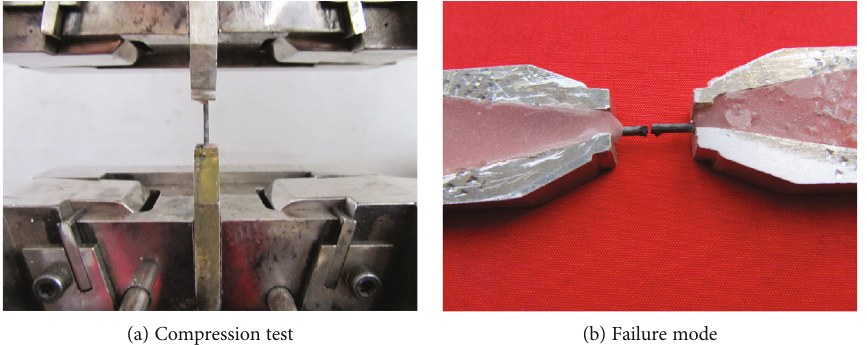
Figure 4: Fiber rod compression experiment and failure mode.